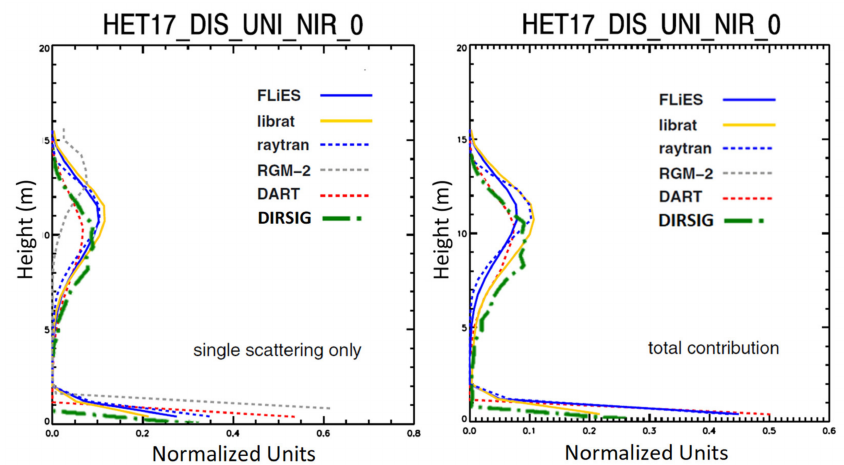
Figure 2. Normalized lidar waveforms from the RAMI-IV study with the DIRSIG-produced waveforms overlapped. The left plot displays waveforms produced from single scatter contributions, while the right figure includes multiscatter (figure adapted from [83]).